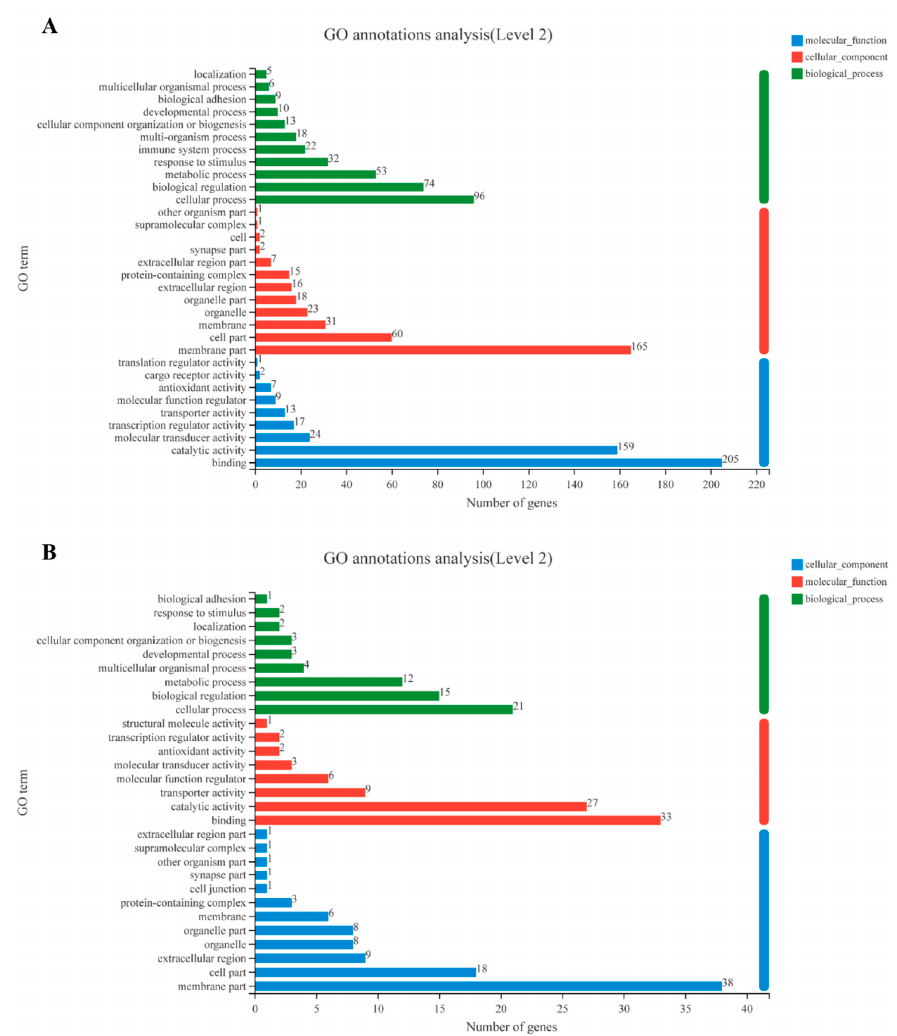
Figure 3. Gene ontology (GO) term enrichment analysis. The GO annotation results were based on the 684 increased DEGs (screened with 2-fold change in the pediveliger stage in comparison with other developmental stages) ( A ) or the 121 DEGs decreased ( B ). Gene ontology categories included molecular function, cellular component, and biological process. GO categories for each function were sorted by increasing order of gene numbers, based on the GO enrichment test; p -value < 0.05.